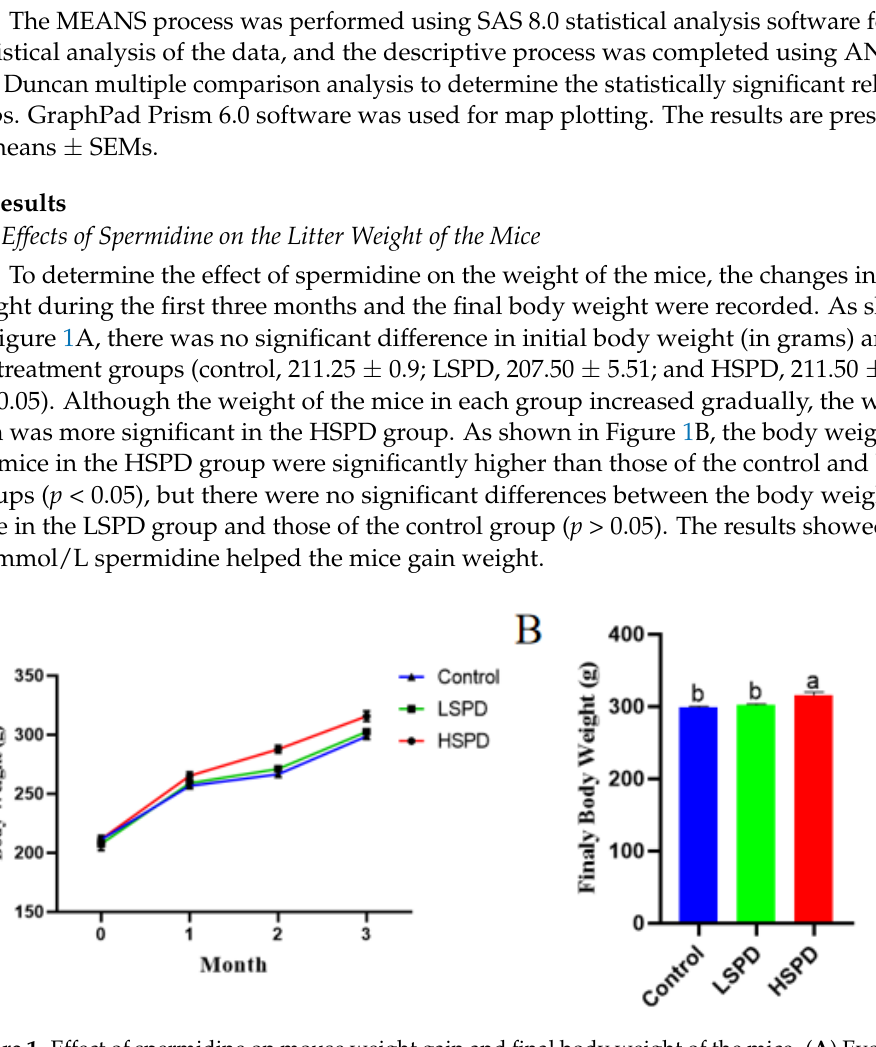
Figure 1. Effect of spermidine on mouse weight gain and final body weight of the mice. ( A ) Evolution of body weight with spermidine. ( B ) Final body weights of the mice consuming spermidine at month 3. a,b: The same row without the same letters indicates a significant difference ( p < 0.05).